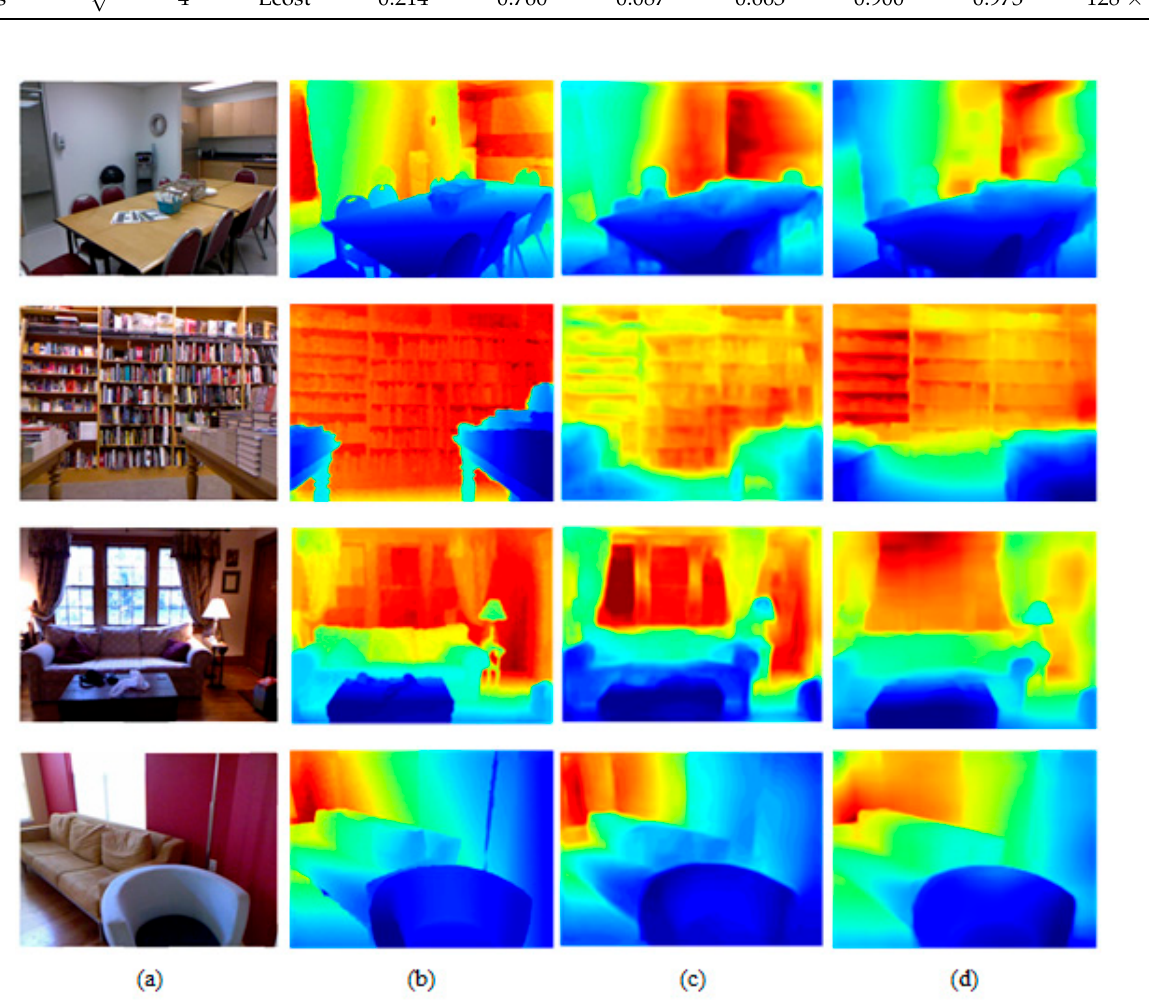
Figure 6. Comparison of monocular depth estimation results of NYU Depth V2 dataset. ( a ) RGB images; ( b ) ground truth; ( c ) Eigen’s method; ( d ) proposed method.